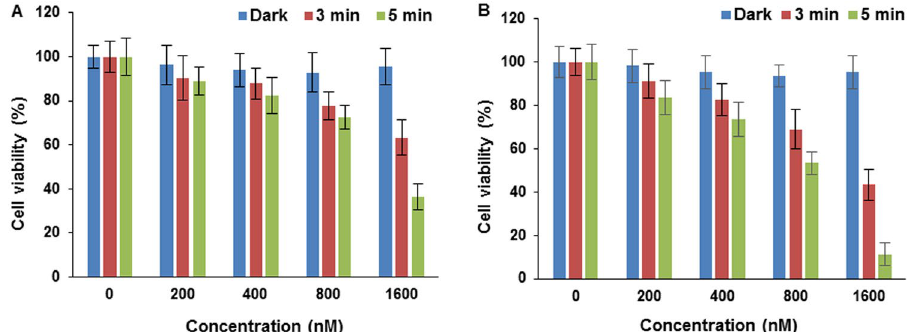
Figure 6. PDT effect of 7 ( A ) and 8 ( B ) KB cells. Cells were incubated with the conjugates at various concentrations and were illuminated for either 3 or 5 minutes. MTT assay was carried out 48 h after light exposure. Data are presented as mean value ± standard deviation (SD) of three independent